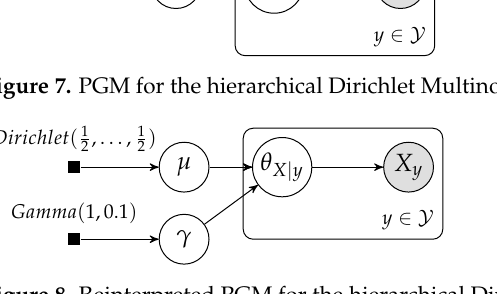
Figure 8. Reinterpreted PGM for the hierarchical Dirichlet Multinomial